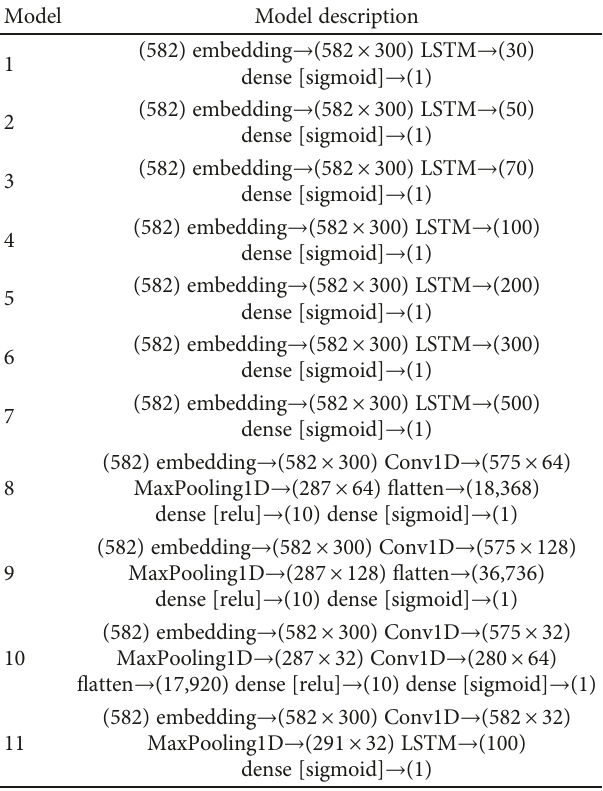
Table 3: Test data set.